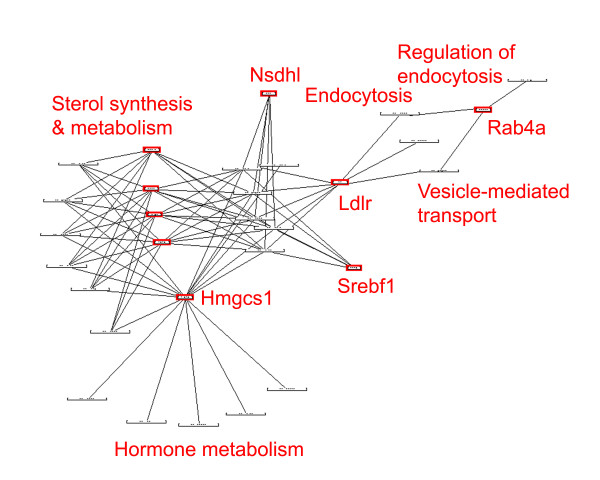
Manipulation and filtering of GTAN to gain insights of overall relationships. The GTAN from Fig. 9 was filtered using the Window from Fig. 10 based on Fisher's exact test result shown in Fig. 7 as reference using cutoff p-value < = 0.05. Genes are highlighted in red. All the terms shown in the network have p-values < = 0.05, some of which are labeled individually and some of which are labeled as summarized descriptions due to close relevancy.